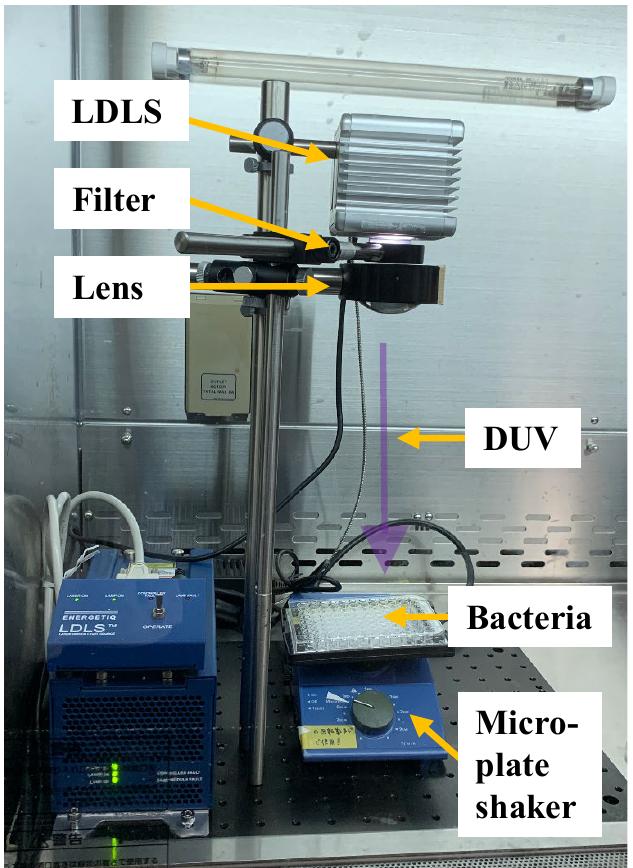
Figure 1. Wavelength-tunable DUV light source. The LDLS, which emits a radiation of 170–2100 nm, was used as a broadband emission source. DUV emission was selected by using a UV band pass filter (Filter) from 200 to 300 nm with a 10 nm bandwidth. The DUV emission (purple arrow) was weakly focused (almost collimated) onto bacteria by a fused silica lens (Lens, diameter of 60 φ) with a focal length of 80 mm. The bacteria were introduced inside the microplate, and during DUV irradiation, the bacteria were agitated by a microplate shaker.